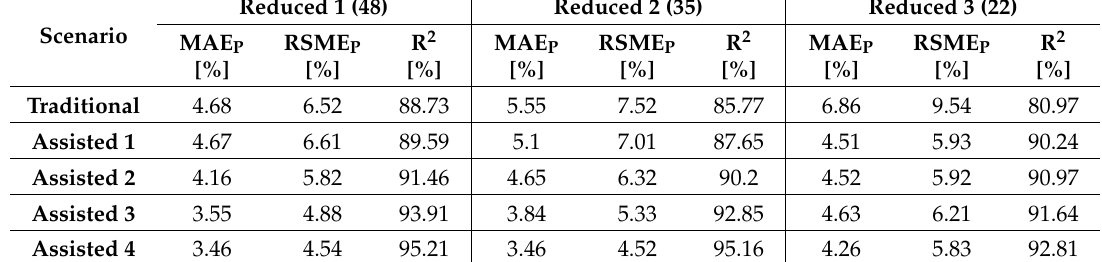
Table 3. Performance metrics for the reduced size training datasets using the traditional and assisted ANN modeling approaches (averages for the 80 random combinations of the testing dataset).